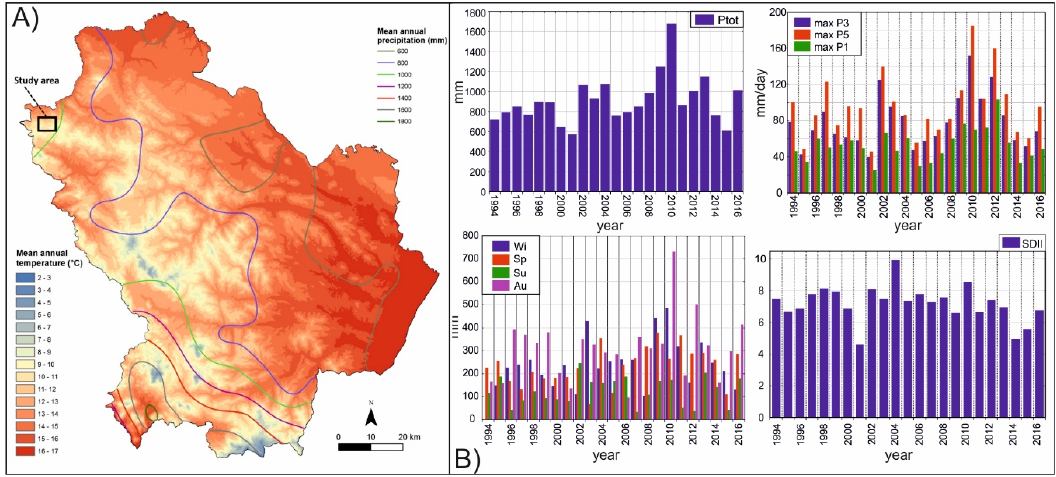
Figure 4. Regional and local climate setting. ( A ) Climate map of the Basilicata region showing the mean annual temperature and rainfall for the 1951–2010 period (Source: Pescopagano weather station); ( B ) Precipitation indices deriving by the hourly rainfall record of the dam weather station. Legend: Ptot: annual rainfall; annual maximum rainfall for 1 (P1), 3(P3) and 5(P5) days. Wi: Winter; Sp: Spring; Su: Summer; Au: Autumn. SDII: simple daily intensity index representing the ratio between the total annual precipitation and the number of annual rainy